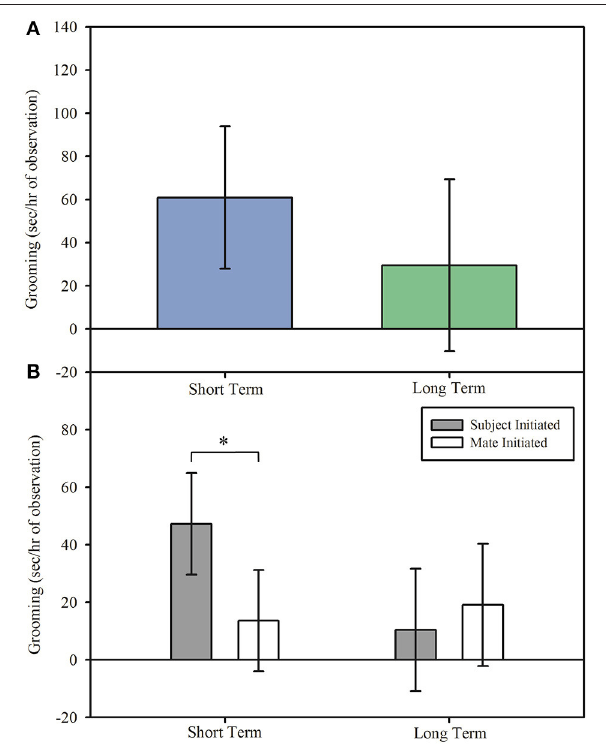
FIGURE 4 | Duration in proximity (model estimates ± SEM) to the opposite sex partner during reunion. (A) Short term marmoset pairs spent less time in proximity during reunion when the female was treated with a dopamine receptor subtype 2 agonist or antagonist compared to when the male was treated with the same compound. Duration in proximity during reunion did not differ when males or females in short term pairs were treated with a dopamine receptor subtype 1 agonist or antagonist or saline. Bars marked with N denote significant within sex differences from saline. Pairs spent less time in proximity during reunion when females were treated with a D2 agonist compared to when females received saline. There were no significant effects within males compared to saline. (B) Long term marmoset pairs spent less time in proximity during reunion when the female was treated with a dopamine receptor subtype 1 agonist or antagonist compared to when the male was treated with the same compound. Duration in proximity during reunion did not differ when males or females in long term pairs were treated with a dopamine receptor subtype 2 agonist or antagonist or saline (significant sex × pair type × treatment interaction). There were no significant within sex treatment effects for either males or females. *Indicates significant difference at p < 0.05. D1 Ant = D1 antagonist, D1 Ag = D1 agonist, D2 Ant = D2 antagonist, D2 Ag = D2 agonist.